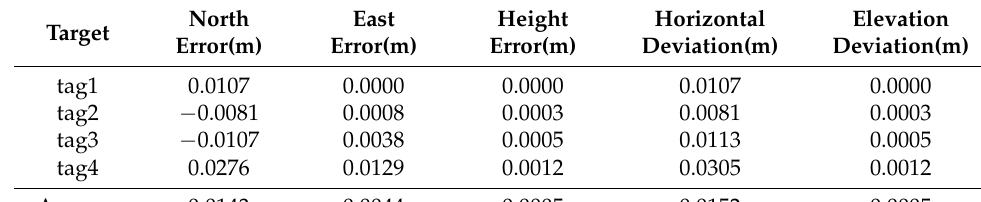
Figure 22. Point cloud extraction target and target measurement position. Table 5. Point cloud extraction target and target measurement error.